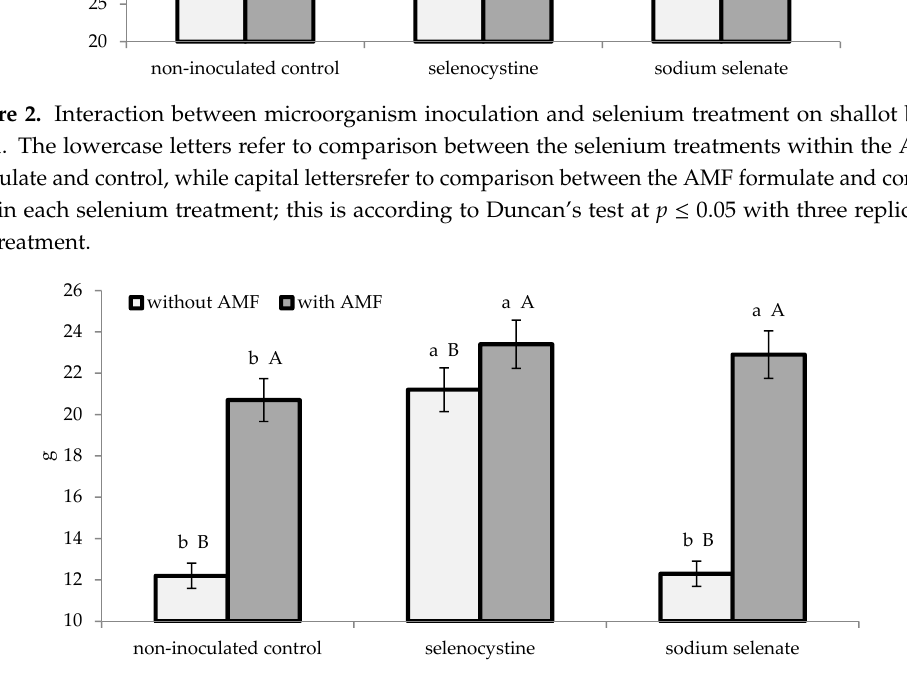
Figure 3. Interaction between microorganism inoculation and selenium treatment on shallot mean bulb weight. The lowercase letters refer to comparison between the selenium treatments within the AMF formulate and control, while capital letters refer to comparison between the AMF formulate and control within each selenium treatment; this is according to Duncan’s test at p ≤ 0.05 with three replicates per treatment.